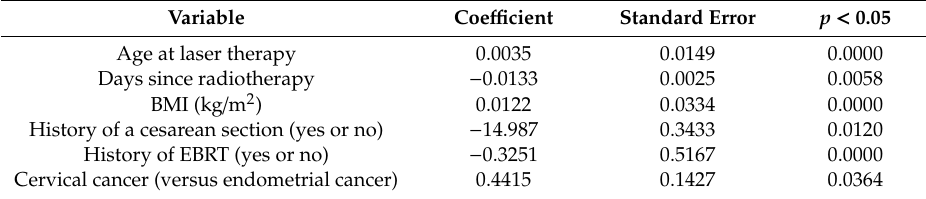
Table 4. Multivariable analysis. Variables associated with vaginal lengthening after laser therapy.